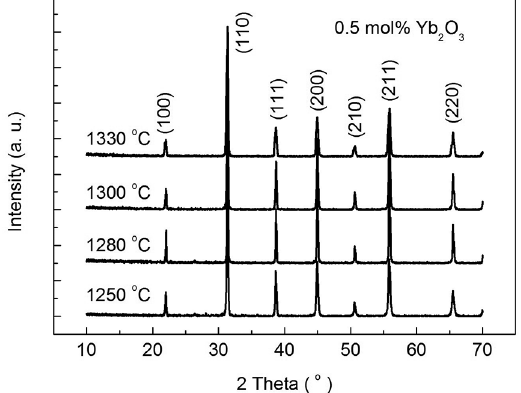
Figure 3: XRD patterns of BZT10 + 0.5 mol% Yb various sintering temperature.